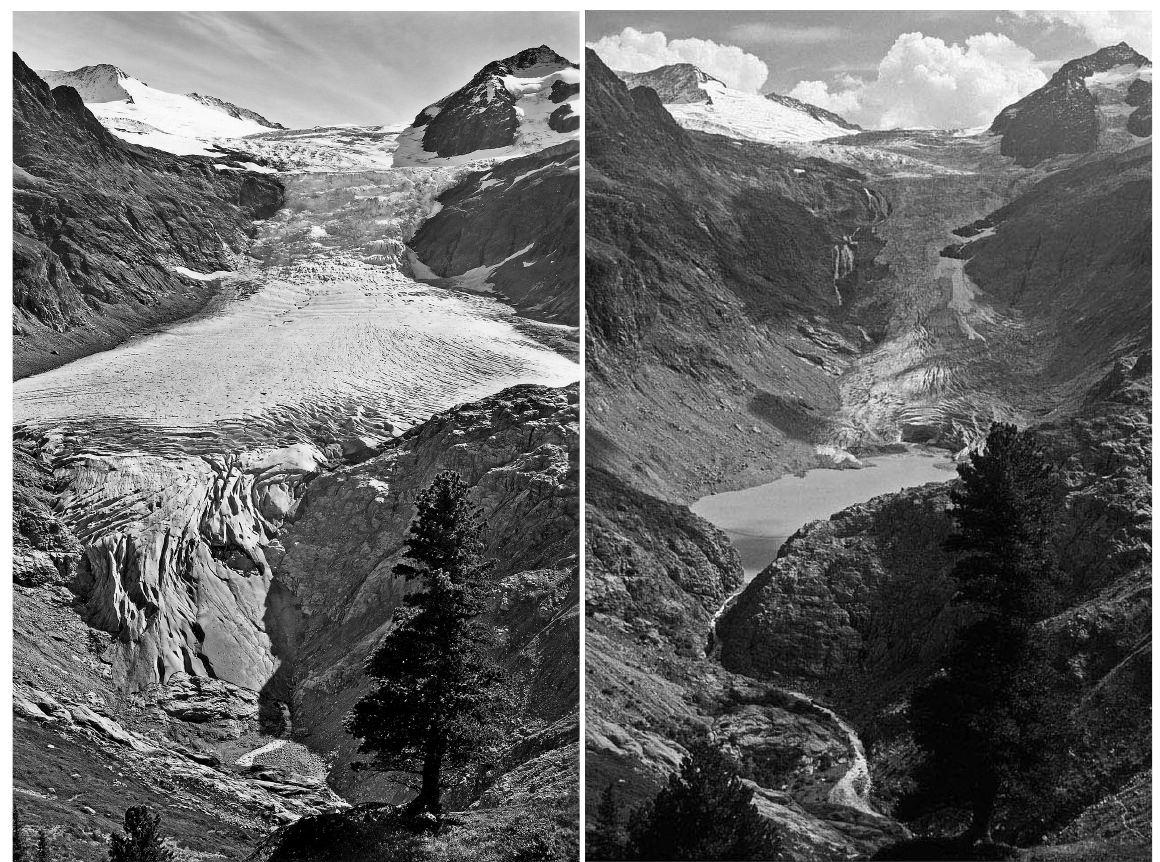
Fig. 3. Tongue of Triftgletscher in 1948 and 2006 (photos: archive Gesellschaft f¨ur ¨Okologische Forschung (http://www.gletscherarchiv.de) and F.